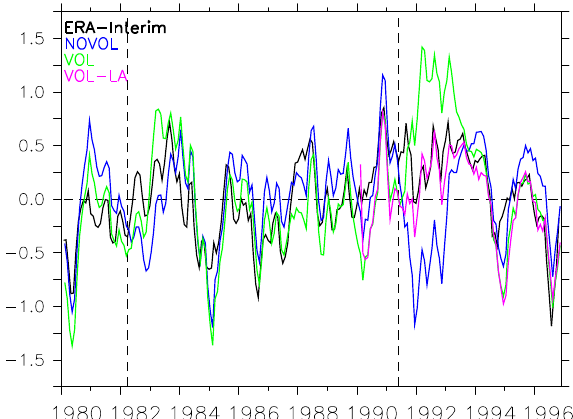
Figure 2. Anomaly of the monthly and zonally averaged tropical (20 ◦ S–20 ◦ N) cold point temperature (K) calculated from ERA- Interim (black) and as simulated in the NOVOL (blue) and VOL (green) simulations. The purple line (VOL-LA) shows the result of a sensitivity simulation (Mount Pinatubo period, only), for which the stratospheric aerosol extinction was scaled by a factor of 0.5. The anomalies have been calculated based on the period 1980–1996 for ERA-Interim, NOVOL and VOL, and 1990–1996 for VOL-LA, and further smoothed with a box-smoother of 3 months length. The vertically oriented dashed lines indicate the eruptions of El Chichón (March 1982) and Mount Pinatubo (June